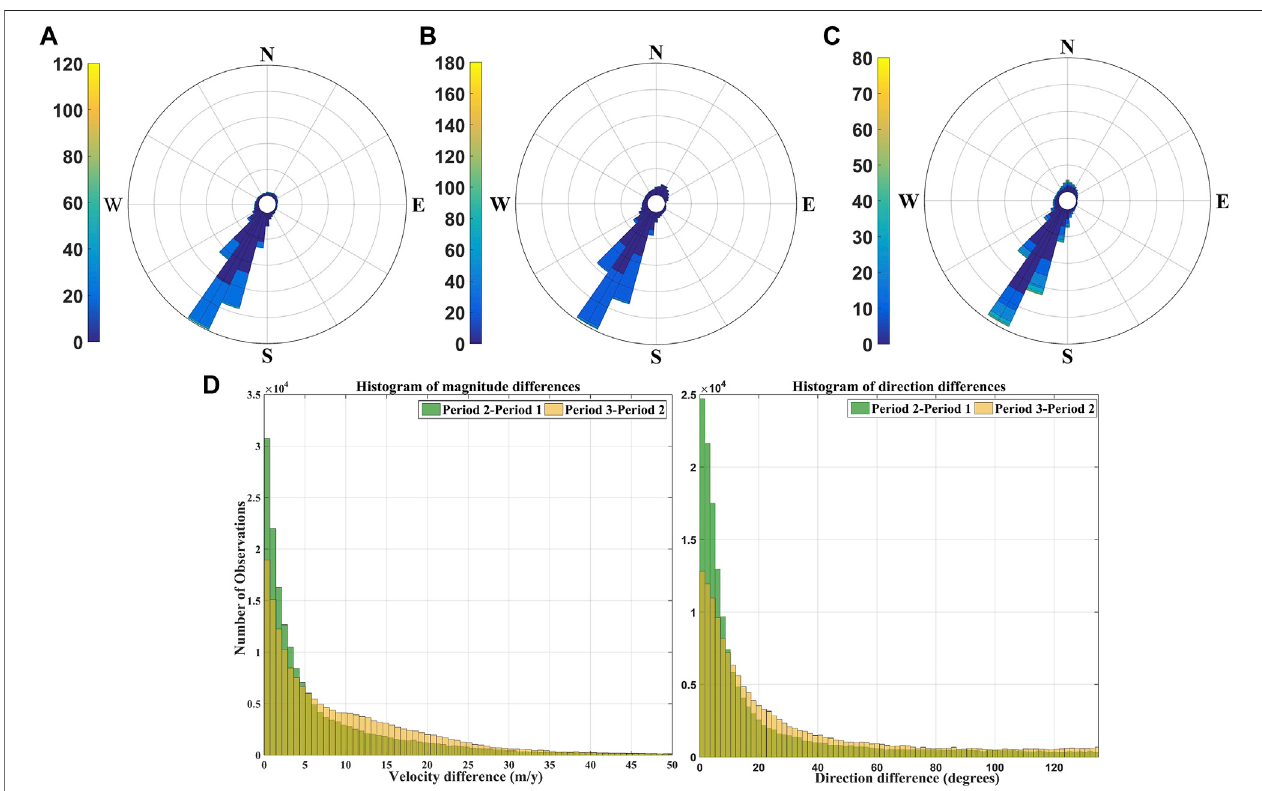
FIGURE12| FrequencydistributionoftheactiveduneandsandypatchesintheBodéléDepressionforthreeobservationperiods: (A) 1984 – 1998, (B) 1998 – 2007, and (C) 2013 – 2021. Units in (A – C) are in m/y. (D) Histogram of the difference between period 1 and 2 and periods 2 and 3 in terms of magnitude (Right) and direction (Left)